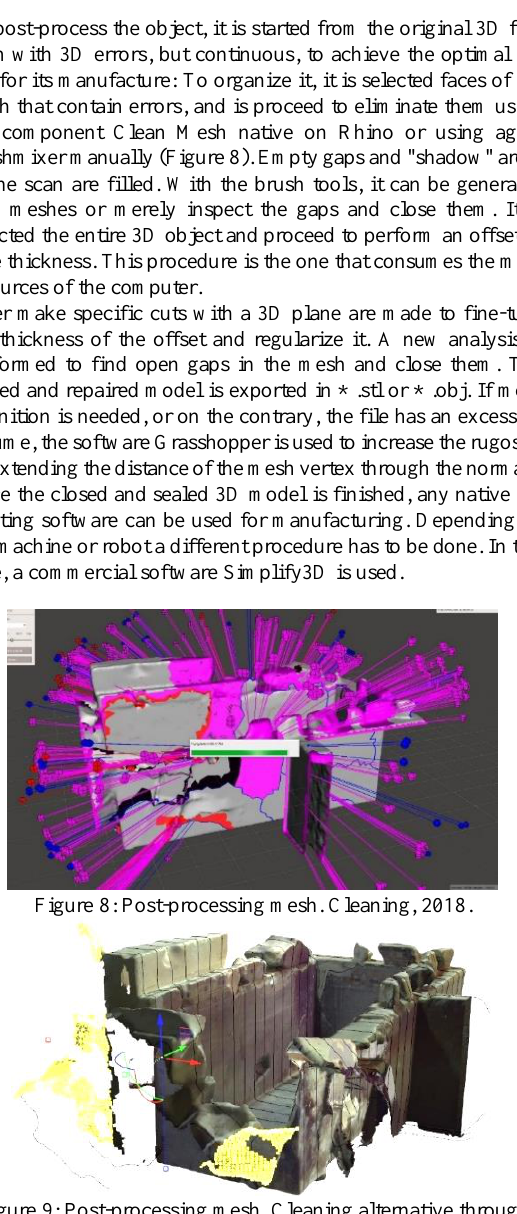
Figure 9: Post-processing mesh. Cleaning alternative through